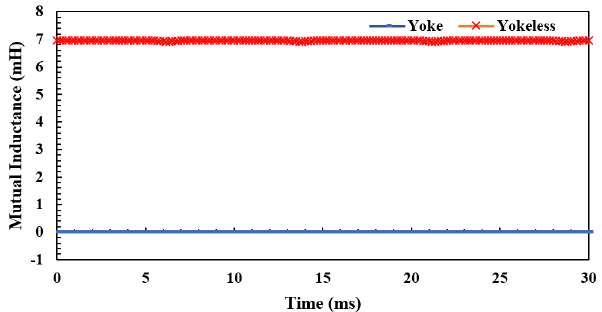
Figure 5. Mutual inductance comparison in DARF-PMVM.